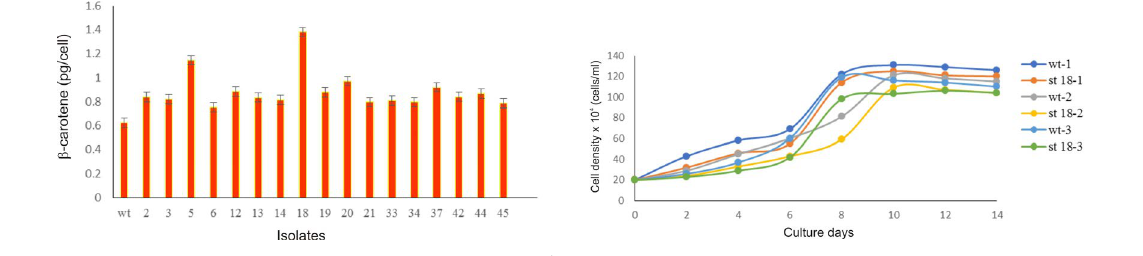
Fig. 6. Growth of wild type (wt) and mutants (mt) in the first cultivation cycle (wt-1, mt KU18-1), the second cultivation cycle (wt-2, mt KU 18-2) and the third cultivation cycle (wt-3, mt KU 18-3) in 2.5M NaCl modified Jonson’s medium under 200 mmol photons m -2 ·s -1